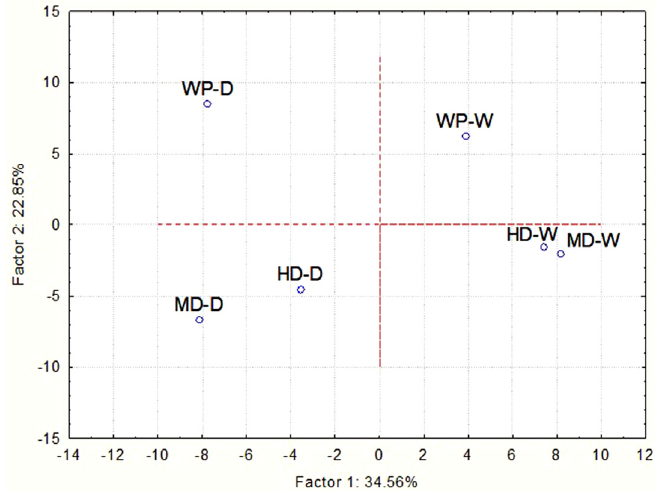
Figure 4. Principal coordinates analyses showing the relationships between fungal communities from forest sites with increasing levels of disturbance (well preserved: WP; moderately disturbed: MD; heavily disturbed: HD) in central Mexico in two contrasting seasons (dry season: D; rainy season: W).